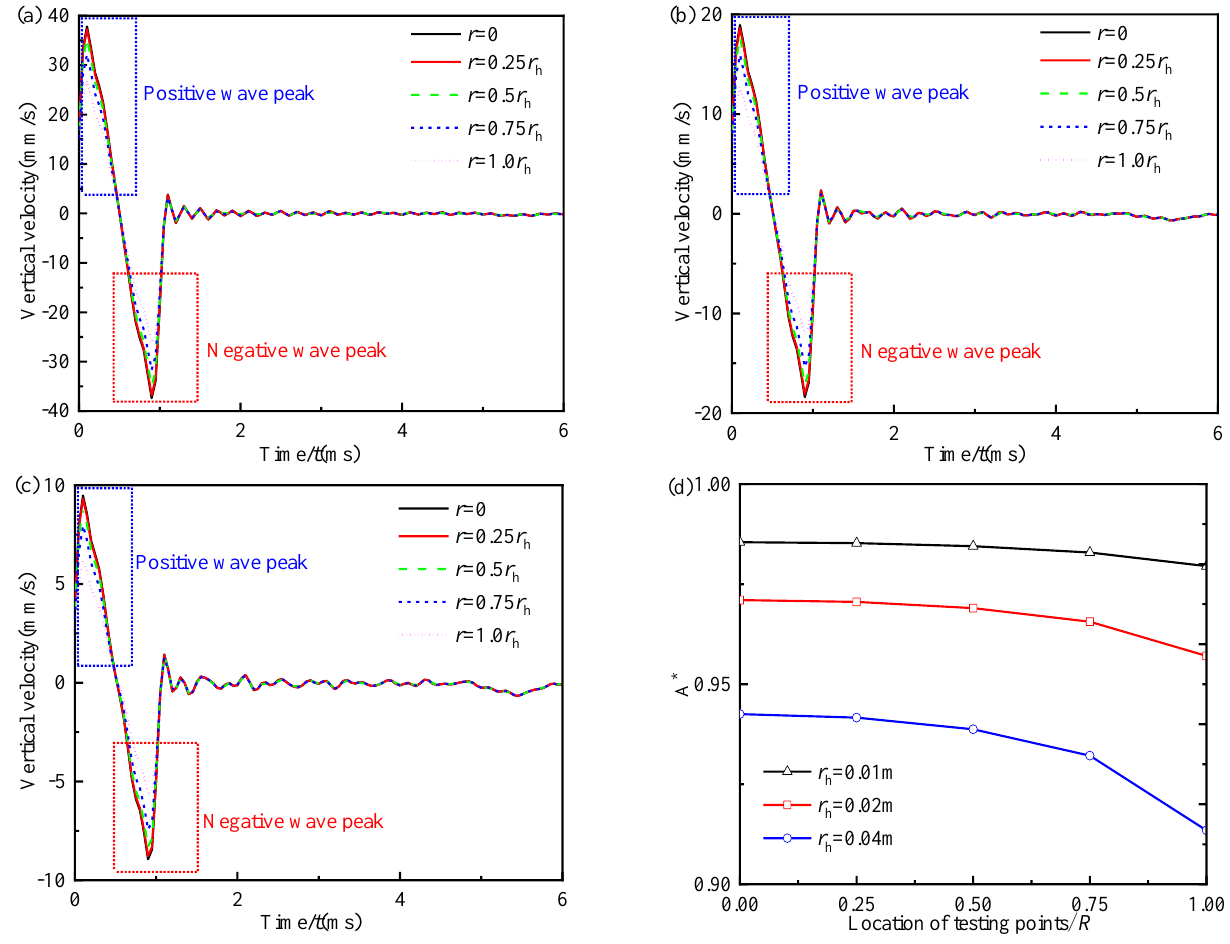
Figure 8. Velocity response in time domain of different test points along the radial direction within the excitation region for pile with R = 1.0 m: ( a ) r h = 0.01 m; ( b ) r h = 0.02 m; ( c ) r h = 0.04 m; ( d ) Variation of the negative-positive-ratio.